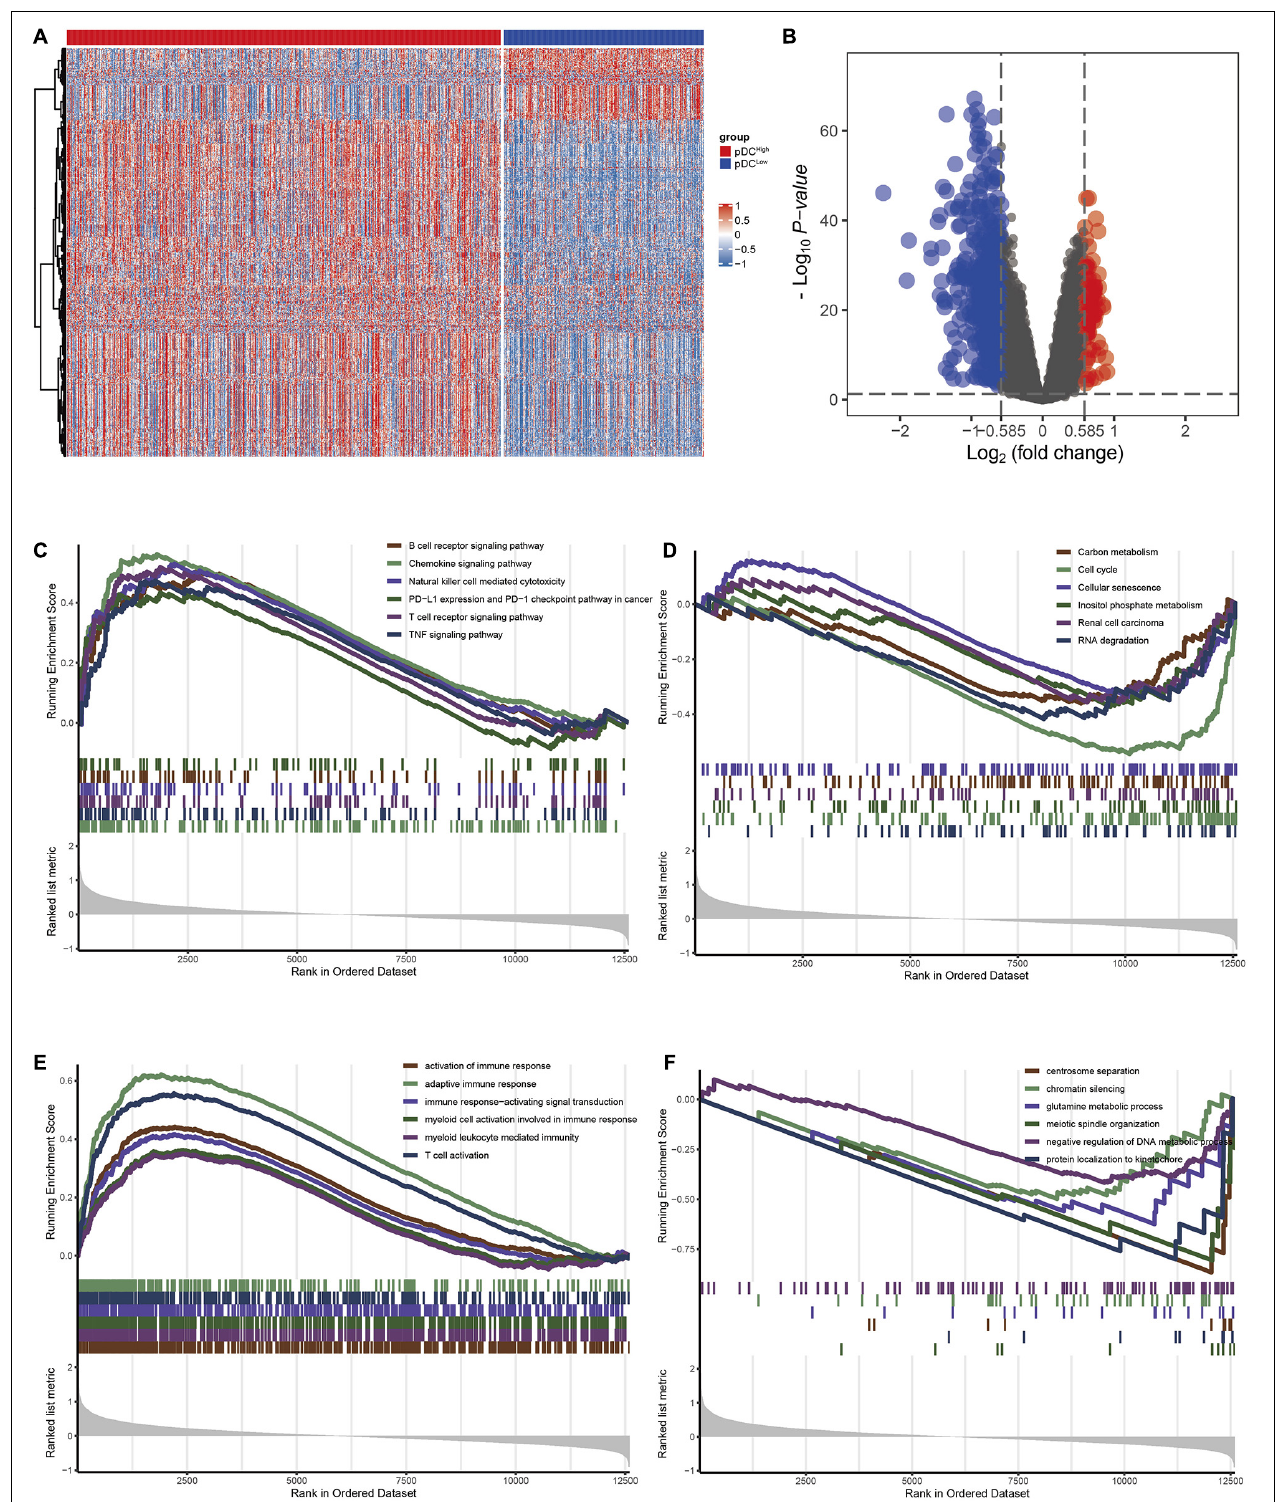
FIGURE 3 | The DEGs and pathways between the two groups. (A) Heatmap of the DEGs between the two groups. (B) The volcano plot of the DEGs between the two groups. (C) KEGG analysis in the pDC high group. (D) KEGG analysis in the pDC low group. (E) GO analysis demonstrated in the pDC high group. (F) GO analysis in the pDC low